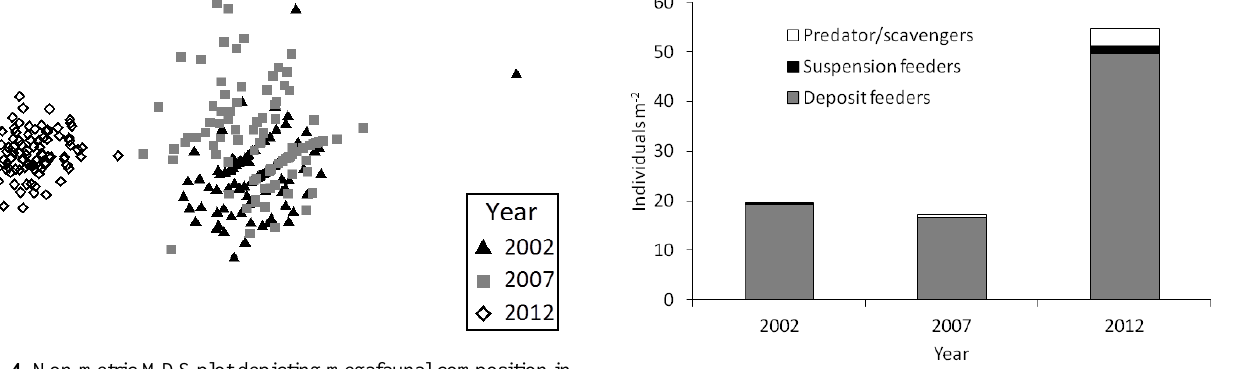
Fig. 4. Non-metric MDS plot depicting megafaunal composition in images from 2002, 2007, and 2012 at station HG I. Data have been square-root transformed. A 2-D stress value of 0.12 indicates a good fit of the data.